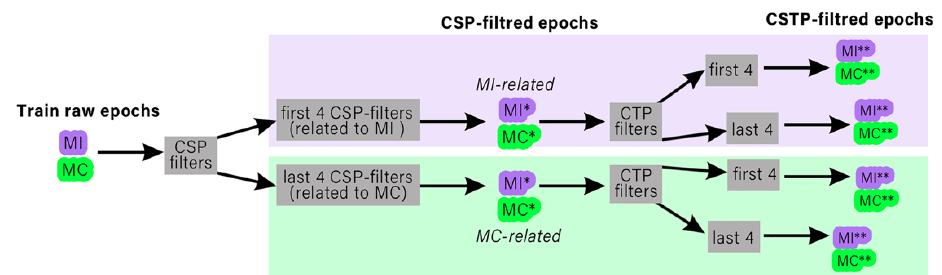
Figure 2. The pipeline of consequent spatial and temporal filtering within the feature extraction. The pair of sets of raw EEG epochs (MI and MC) were used to create CSP-filters; then, the raw epochs were processed by eight CSP filters (first four and last four). Two sets of spatially-filtered epochs (MI* and MC*) were used to create CTP filters; on the last step, eight CTP filters (corresponding to the 4 largest and smallest eigenvalues) were selected from each of the CTP filter matrices and the spatially processed EEG epochs were filtered through each one. MI** and MC** are the resulting CSTP-filtered epochs.